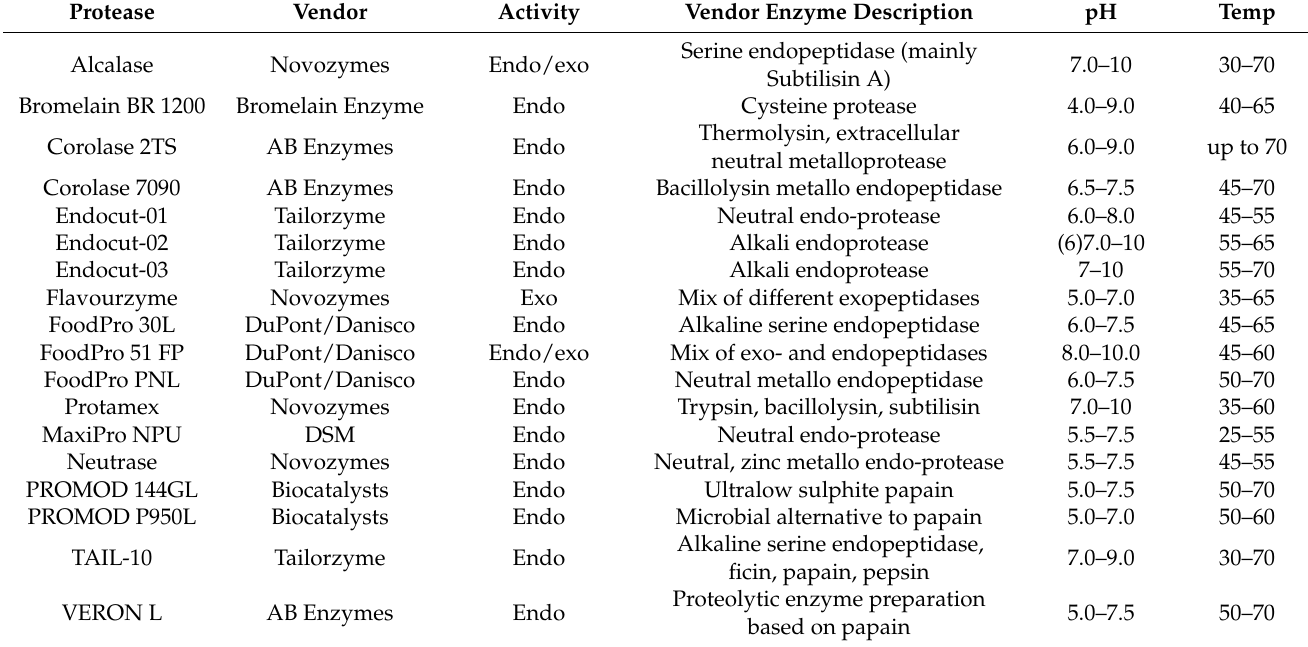
Table 6. Protease information. The commercial name, vendor and properties of all proteases are included in the first azo-casein